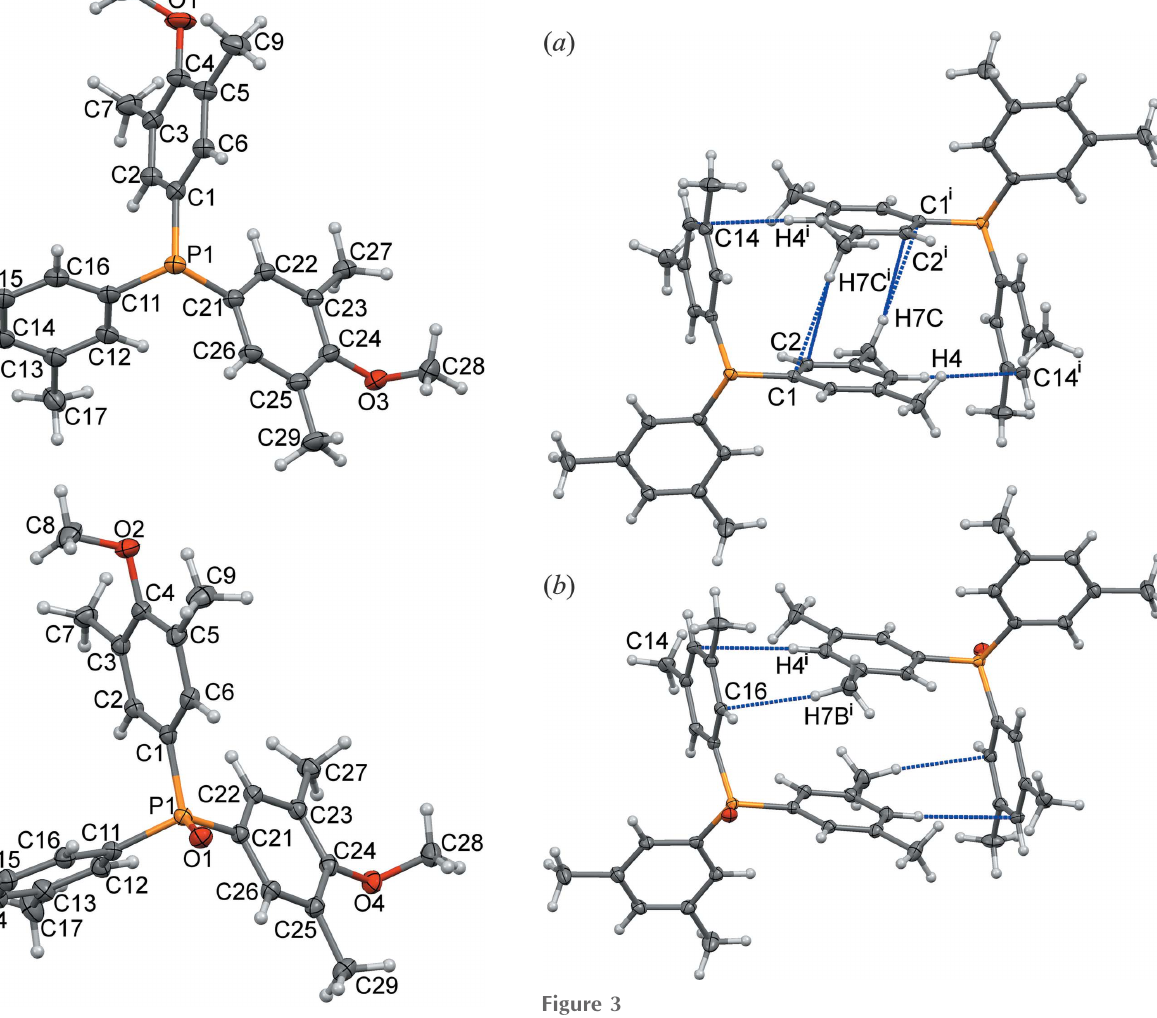
Figure 3 Stacking interactions ( (cid:2) – (cid:2) and ‘T’ type) linking centrosymmetric pairs of ( a ) phosphine (I) and ( b ) phosphine oxide (II), which is a likely cause of the conformations adopted by the C1 rings. [Symmetry code: (i) (cid:5) x , 1 (cid:5) y , (cid:5) z ].